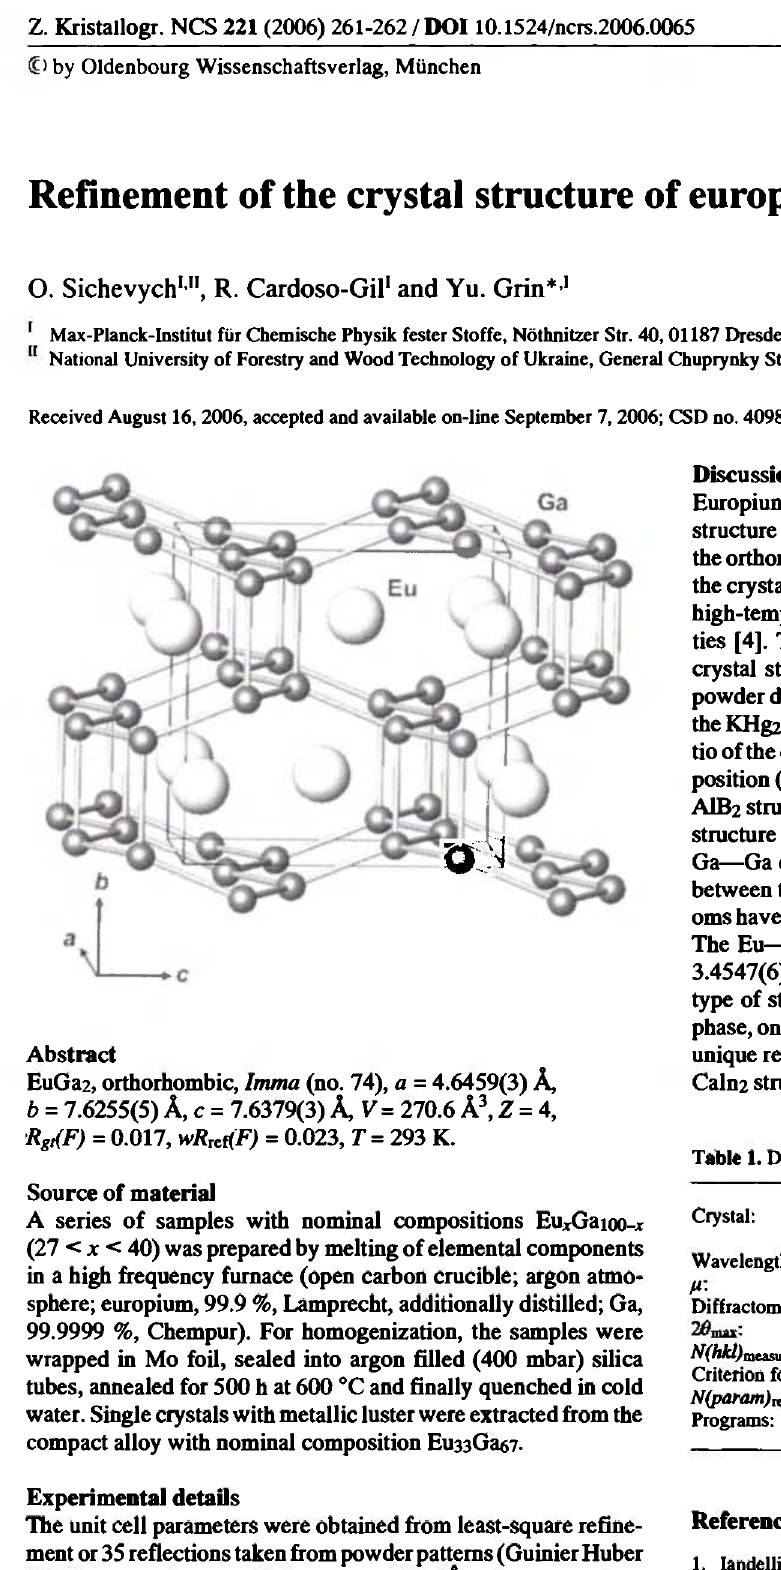
Table 2. Atomic coordinates and displacement parameters (in A 2